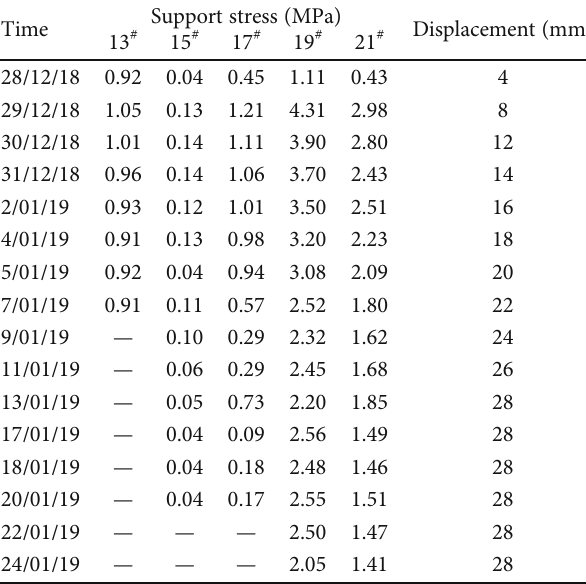
Table 8: Monitoring results: support stress and displacement of Section I (E03-Y8+11m).